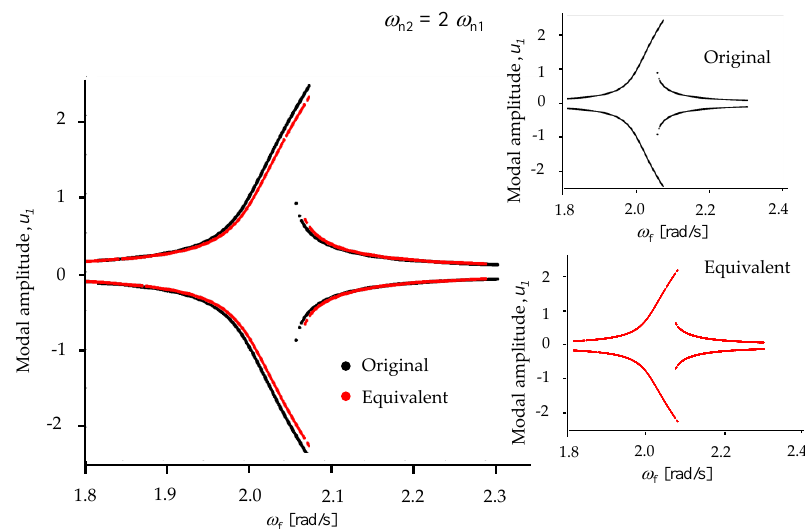
Figure 14. Bifurcation diagrams computed from the numerical integration solutions of Equations (29) and (43). The parameter values used to obtain these curves were 𝑚 1 = 10 kg, 𝑚 2 = 0.6 kg, 𝑐 1 = 0.1 Ns/m, 𝑐 2 = 0.08 Ns/m, 𝑘 1 = 44 N/m, 𝑘 2 = 8 N/m 3 , 𝑘 3 = 9.016 , 𝑘 4 = −0.65 N/m 3 , and 𝑓 0 = 0.37 N, with 𝜔 𝑛2 = 2𝜔 𝑛1 . Here, the black line represents the bifurcation diagram computed from the numerical integration solutions of Equation (43), while the red line describes the one obtained from Equation (29).